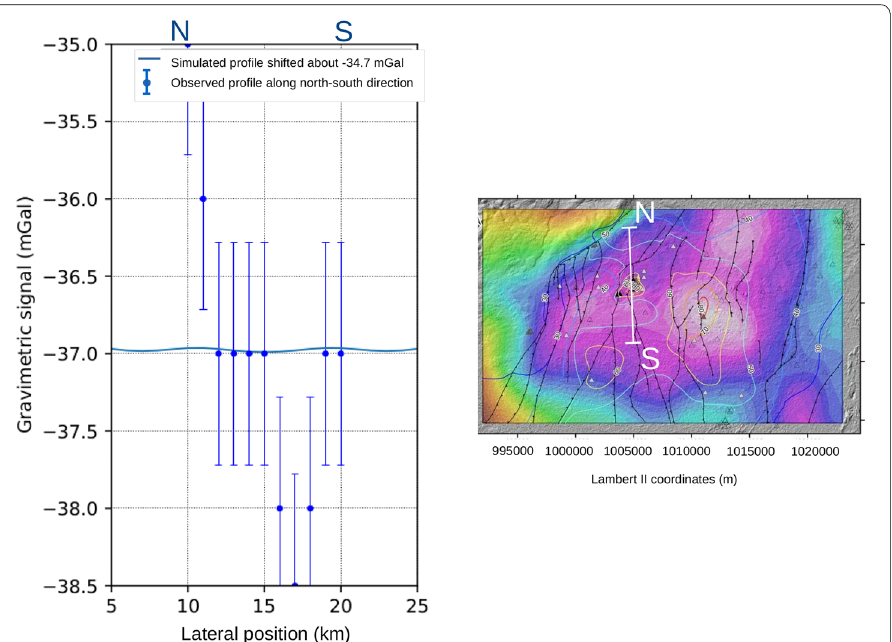
Fig. 9 (Left) Comparison between the calculated gravimetric profile from the 2D model and the observed profile from Baillieux et al. (2014) (as blue points with associated errors). (Right) Map of Bouguer anomalies that include the location and the north–south direction (white line) of the extracted gravimetric